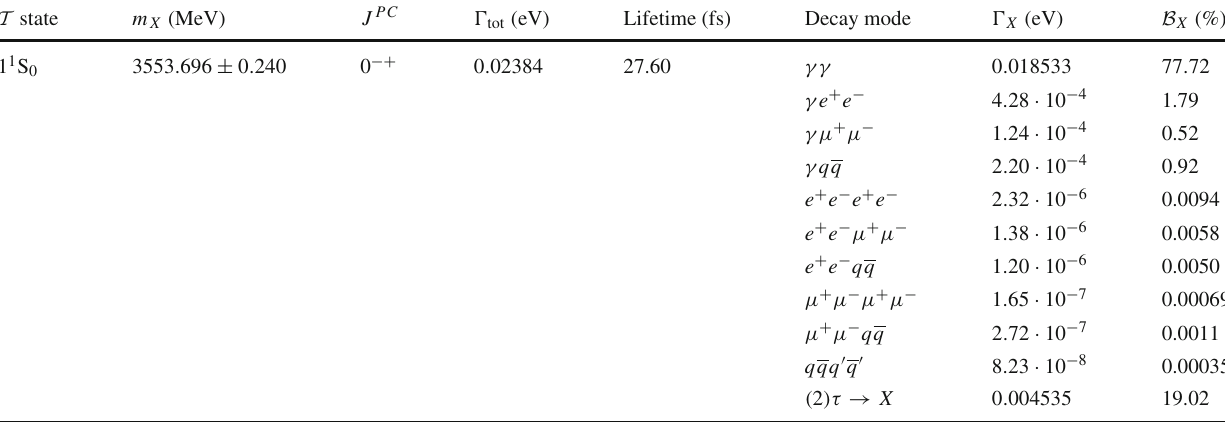
Table 4 Main properties (mass m X , J PC quantum numbers, total width (cid:15) tot , lifetime, as well as partial decay widths (cid:15) X and associated B X branching fractions) of the lowest-energy para-ditauonium bound state computed in this work